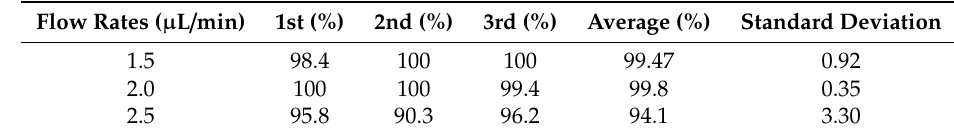
Table 1. Separation e ffi ciencies of prostate cancer cells (PC3) cells in deterministic lateral displacement (DLD) module, at di ff erent flow